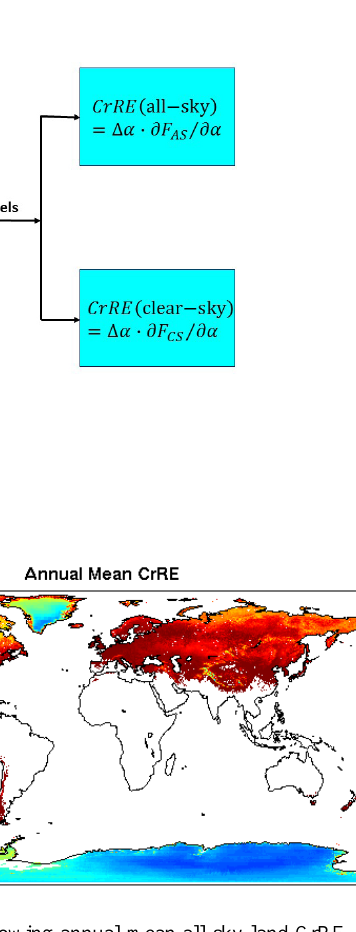
Figure 2. Map showing annual-mean all-sky land CrRE, averaged over 2001–2013, derived with the CAM4